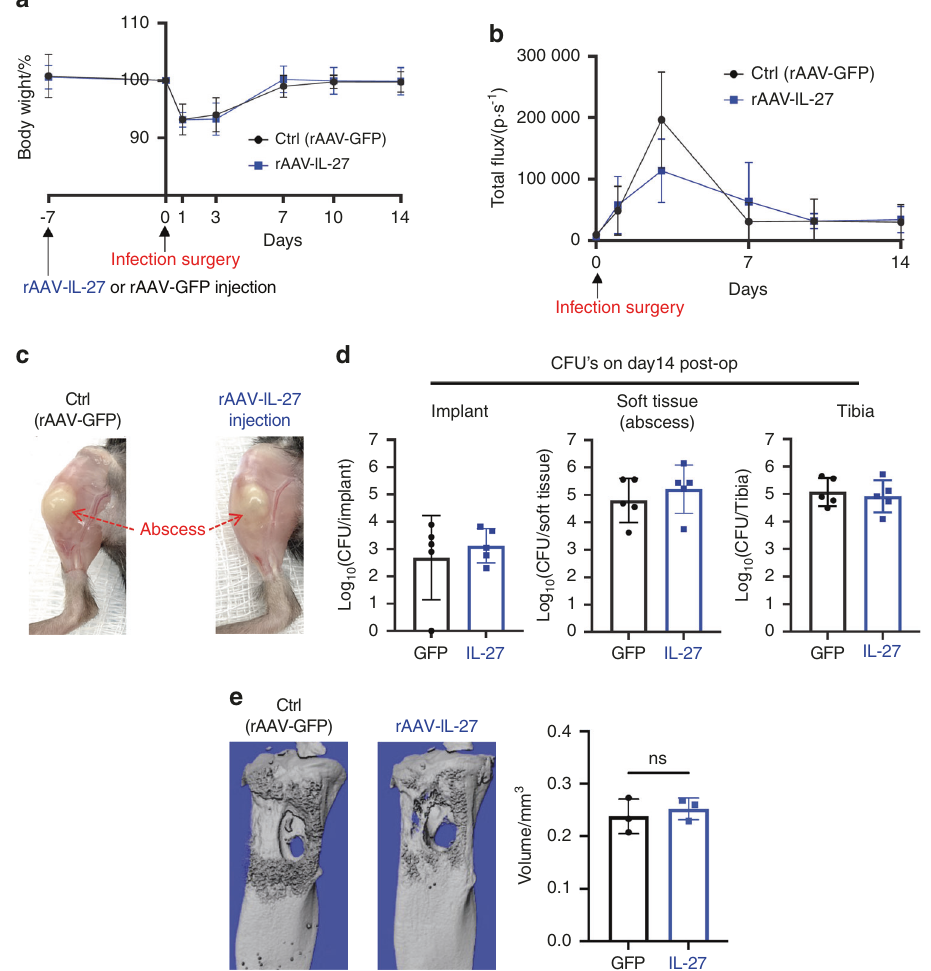
Fig. 6 The effects of IL-27 on implant-associated osteomyelitis depend on IL-27R α expression. Female IL-27R α − / − mice ( n = 5) were injected with rAAV-IL-27p28 or rAAV-GFP and challenged with a MRSA-contaminated transtibial implant as described in Fig. 3. Animal weights ( a ) and BLI values ( b ) were measured on Days 0, 1, 3, 7, 10 and 14, and the data are presented as the mean ± SD for the group ( n = 5). c Representative photographs acquired on Day 14 post-surgery show similar large draining abscesses in both groups. d CFUs in the implant, surgical site soft tissue, and tibia were quanti fi ed after euthanasia on Day 14 post-surgery, and the data for each tibia are presented with the mean ± SD for the group ( n = 5). e Peri-implant osteolysis on Day 14 was evaluated by μ CT analyses ( n = 3). No differences were observed between the experimental